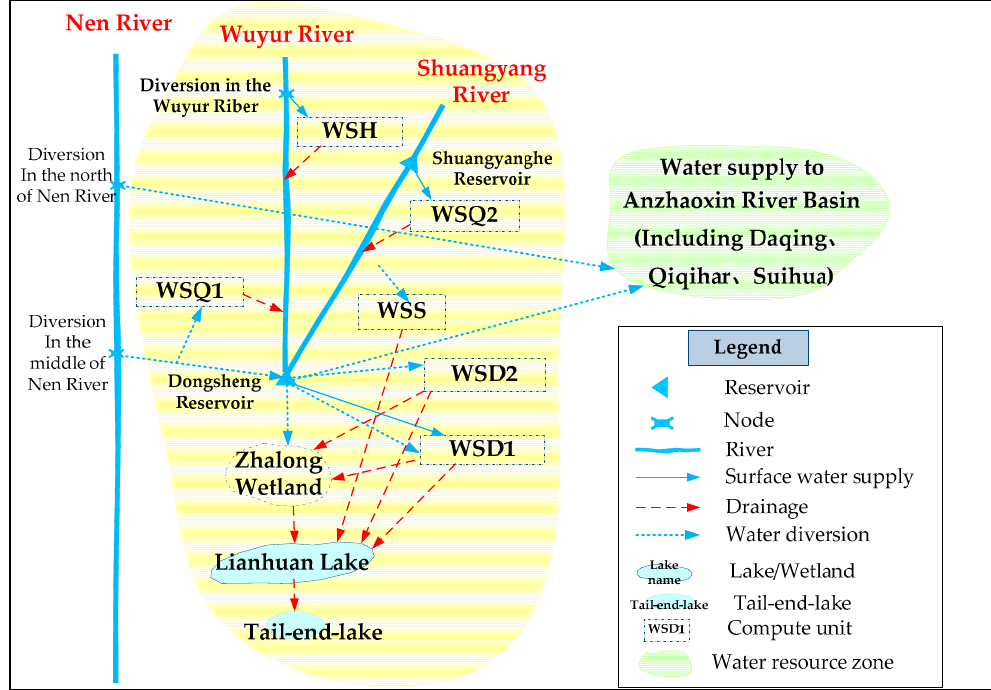
Figure 6. The water resources allocation network chart of the Wuyur river basin.